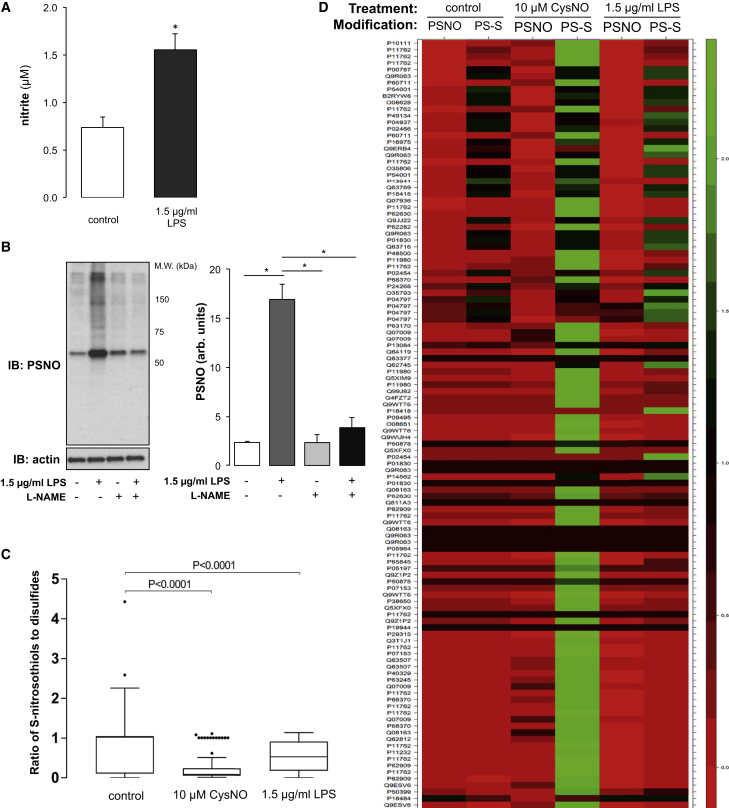
Protein Thiols that Form S-Nitrosothiols Preferentially Form Disulfides(A) Using the Griess assay, an increase in nitrite was detected in SMCs treated with LPS for 18 hr, signifying elevated NO production.(B) Increased NO production correlated with a small but significant increase in PSNO. Increased PSNO was attenuated after treatment with the pan-specific NOS inhibitor L-NAME. Data are represented as mean ± SEM; ∗p < 0.05.(C) PSNO and disulfides were labeled with iodoTMT sixplex reagents in SMCs treated with 10 μM CysNO, 1.5 μg/mL LPS, or under control conditions. Analysis by LC-MS/MS showed that the ratio of S-nitrosothiol to disulfide significantly decreased after SMCs were exposed to exogenous or endogenous nitrosative signaling.(D) The heatmap depicts the scaled and centered peptide peak area of iodoTMT-labeled PSNO or disulfide (PS-S) peptides under each condition. Accession numbers indicate the modification of an individual cysteine residue within a given protein. The color tracker represents the Z score for each cysteine modification and ranges from 0 (red), representing low-abundance modifications, to 2 (green), representing high-abundance modifications.